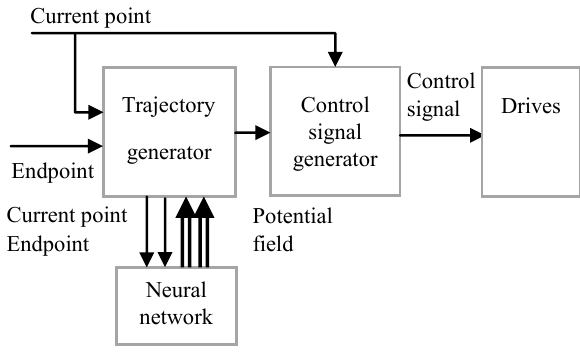
Fig. 3. OD auxiliary movement system architecture